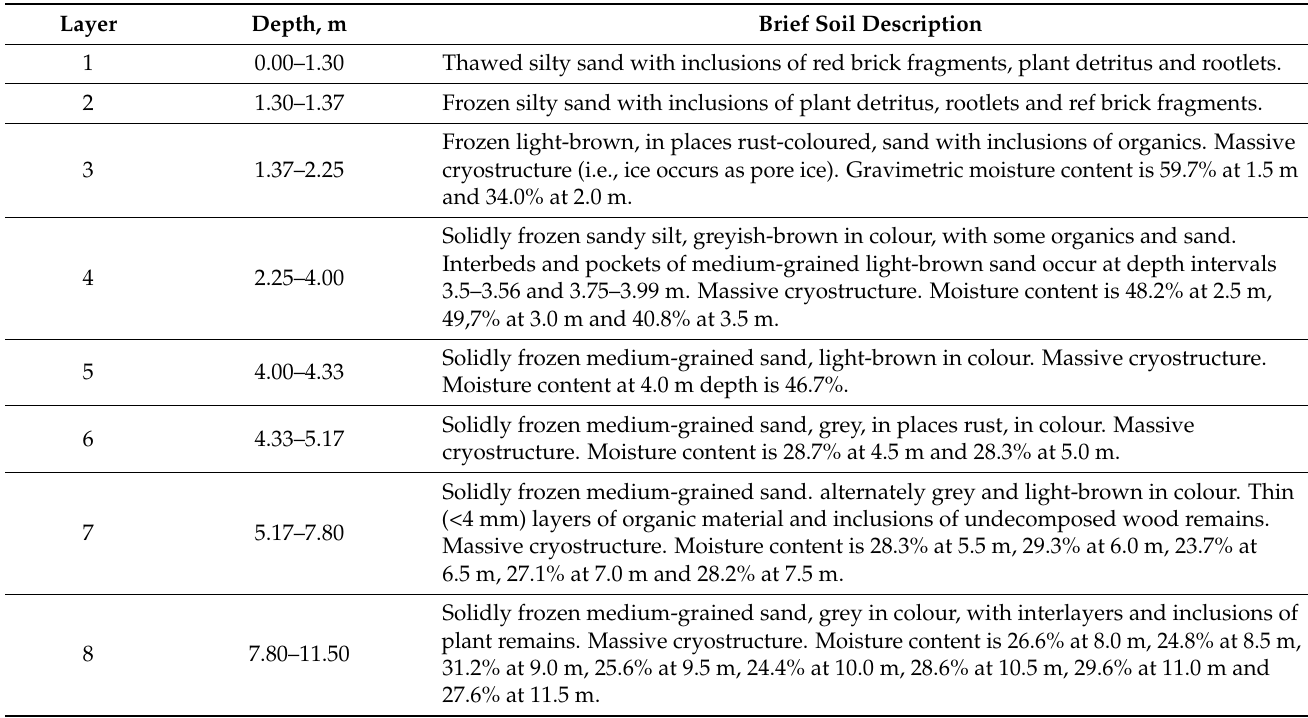
Table 4. Ground temperatures in borehole # 60, ° C.